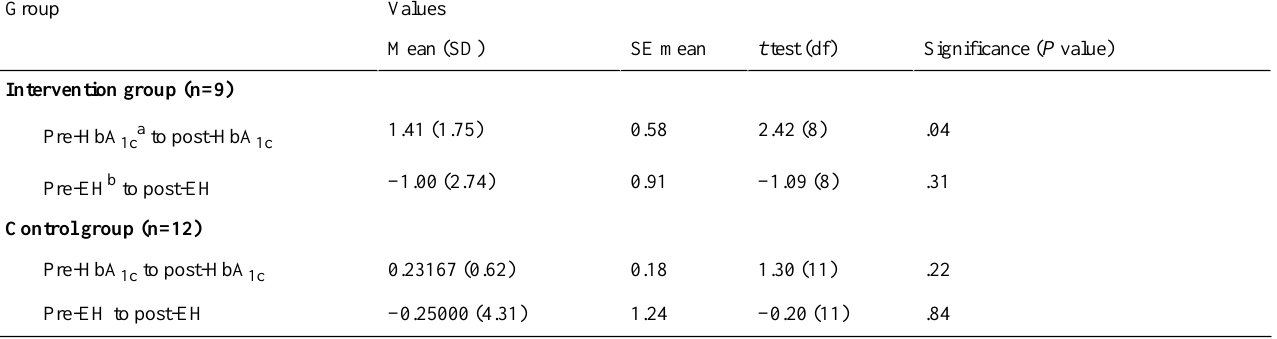
Table 5. Dependent samples t test on both glycated hemoglobin and eating habits for both groups.